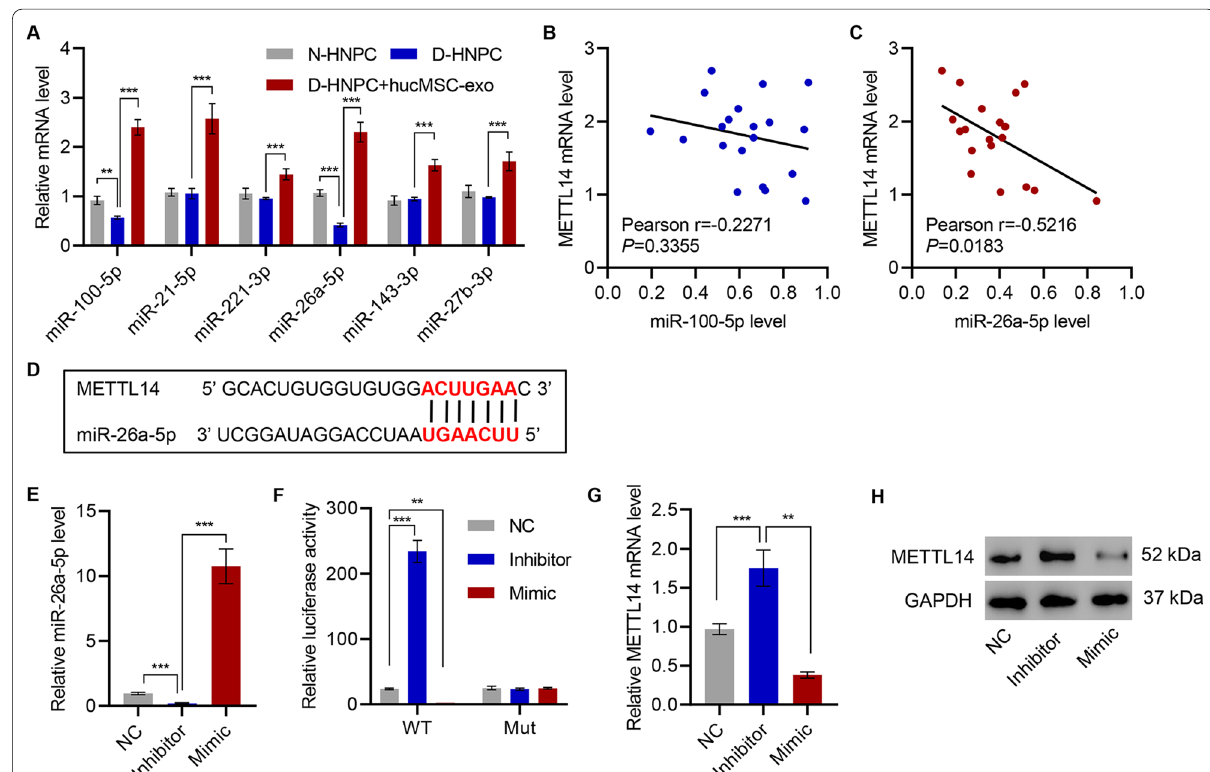
Fig. 3 HucMSC-secreted exosomal miR-26a-5p targets METTL14 in HNPC. A Expression of miR-100-5p, miR-21-5p, miR-221-3p, miR-143-3p, and miR-27b-3p in HNPC with or without hucMSC coculture. B , C Pearson correlation scatter plots in D-HNP tissues ( n between miR-26a-5p and METTL14. E , G , H Relative expression of miR-26a-5p and METTL14 in D-HNPC transfected with miR-26a-5p mimic or its inhibitor. F Effect of miR-26a-5p mimic or its inhibitor on the luciferase activity of METTL14 3 ′ -UTR wild type (WT) or mutant (Mut) in D-HNPC. ** P < 0.01, *** P <